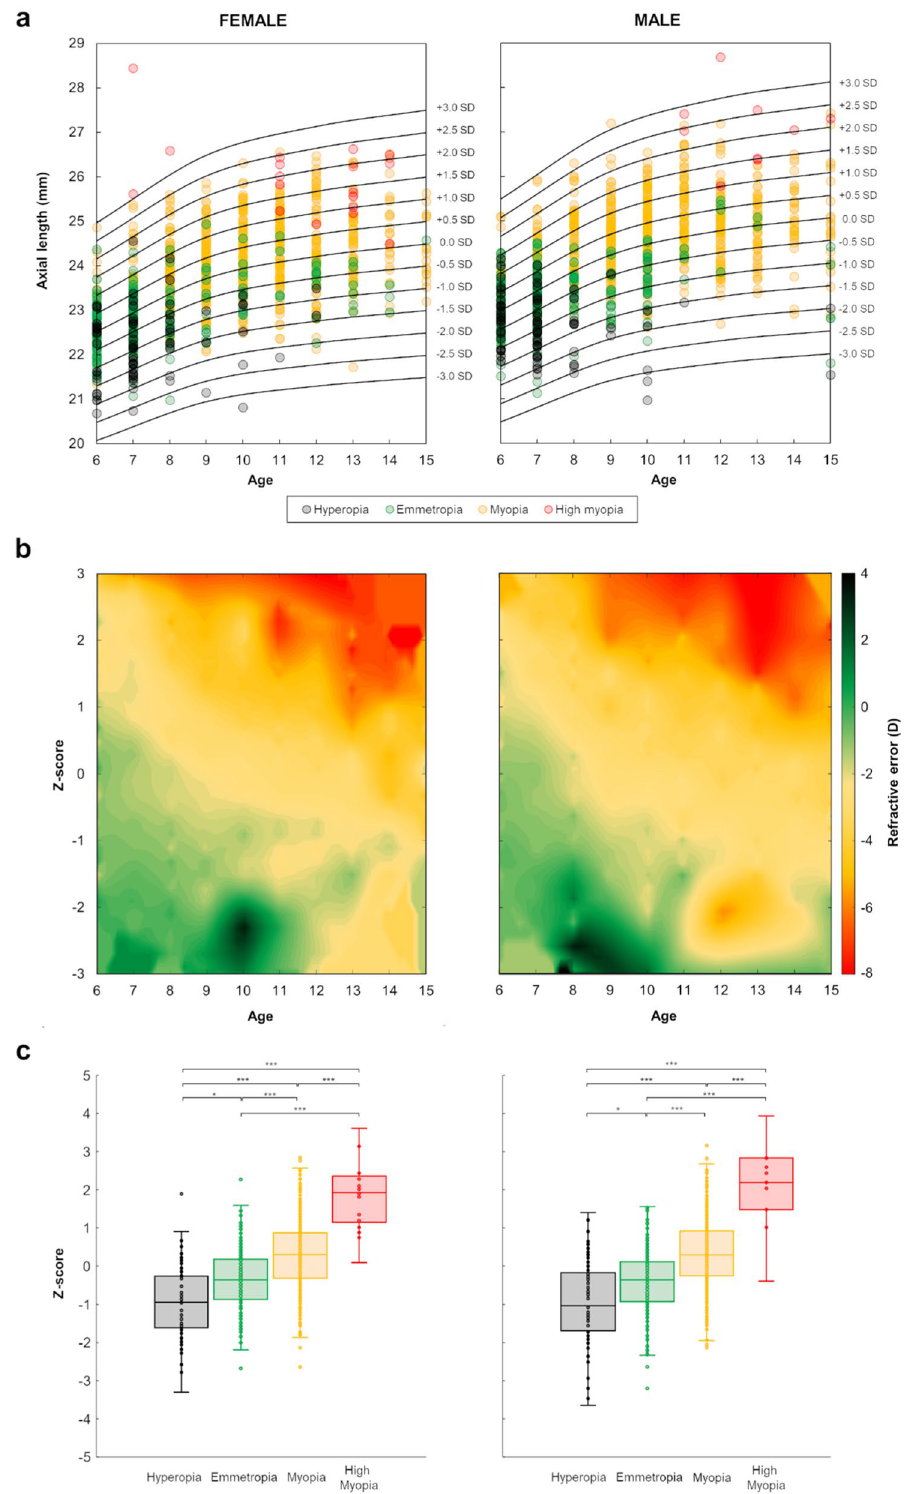
Figure 2. Z-scores based on axial length, age, and refraction. Female group (left) and male group (right). ( a ) Z-scores calculated from the second cross-sectional dataset and superimposed on the Z-score curves derived from the first cross-sectional dataset. ( b ) Refractive error distribution as a function of Z-scores and age. ( c ) Boxplots of Z-scores as a function of refractive condition. Statistical significance: *p < 0.05, **p < 0.01, ***p <